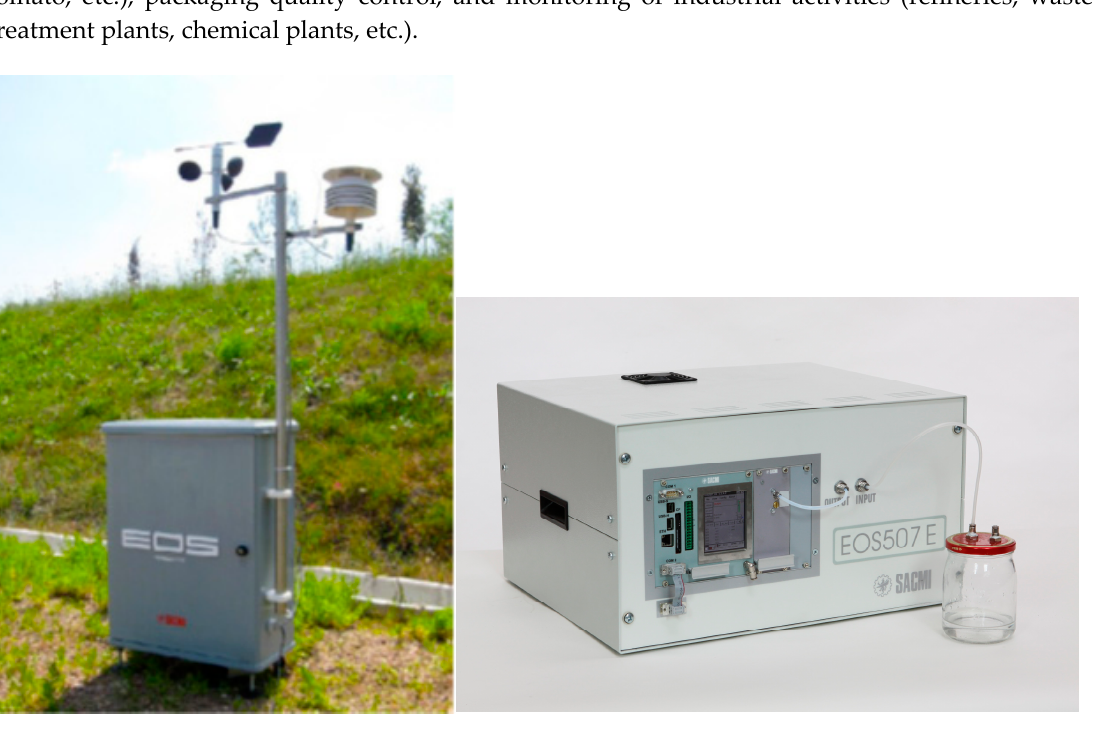
Figure 2. SACMI Electronic Olfactory Systems for outdoor ( left ) and laboratory ( right )